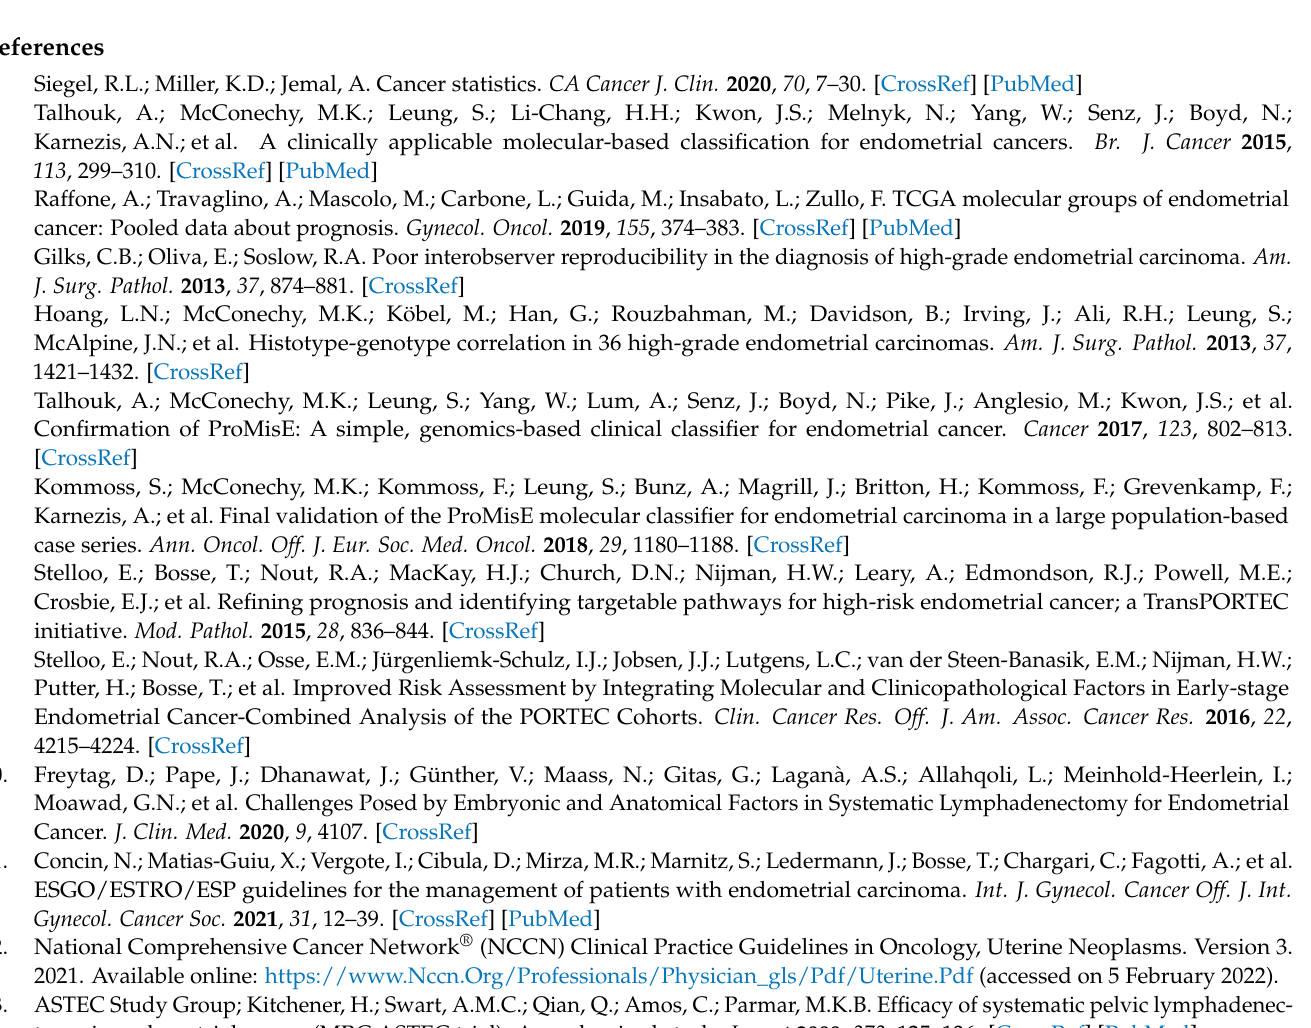
studies; Table S4: Details about sentinel lymph node biopsy; Table S5: Details about sentinel lymph node biopsy and systematic